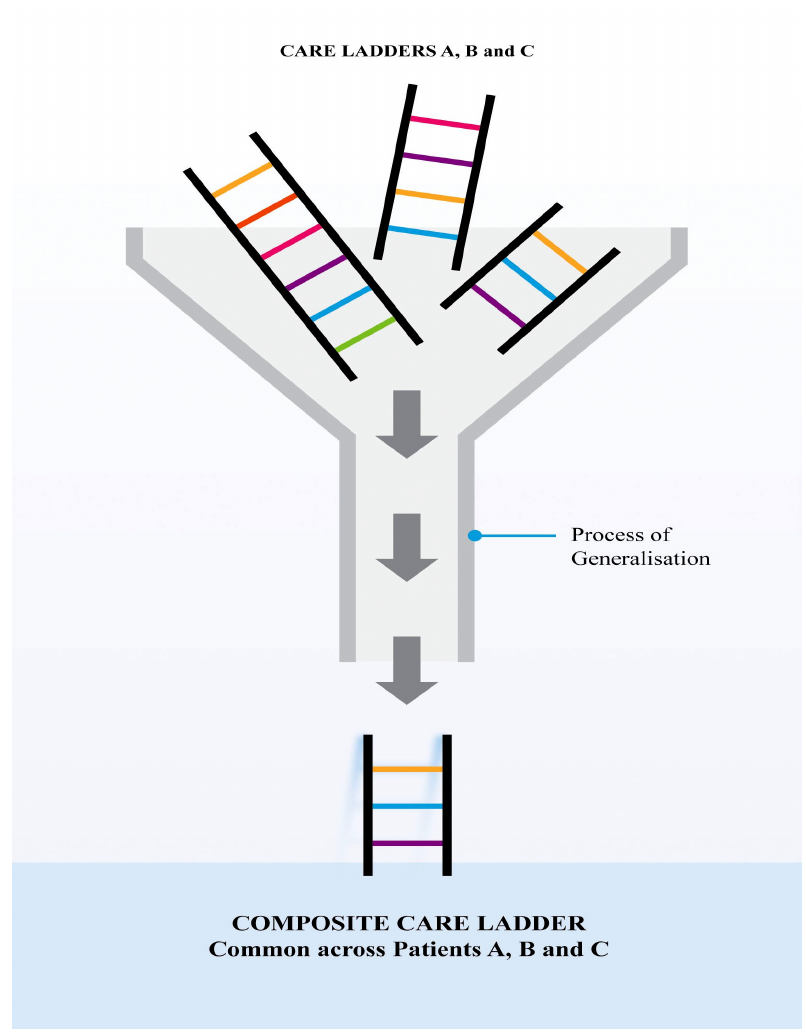
Figure 2. Construction of the composite care ladder from a multiplicity of care ladders.